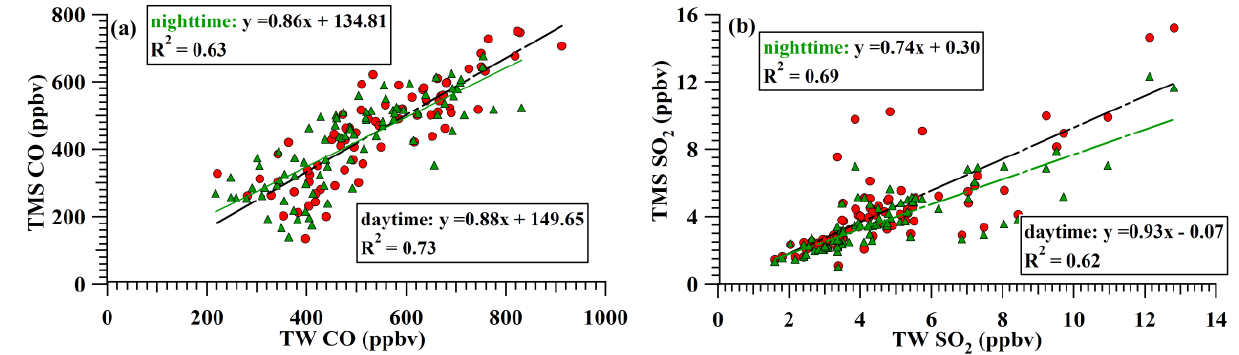
during daytime and nighttime hours between TMS 2